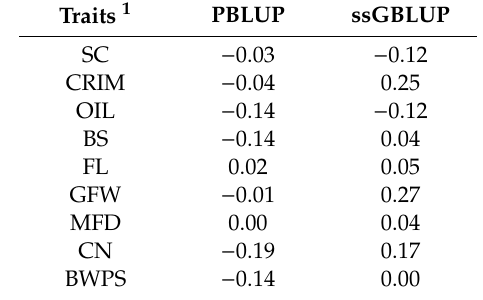
Table A1. Geweke diagnostic results of the convergence of Gibbs chains for wool traits using the pedigree relationship matrix (PBLUP) and combined genomic–pedigree matrix (ssGBLUP). Traits 1